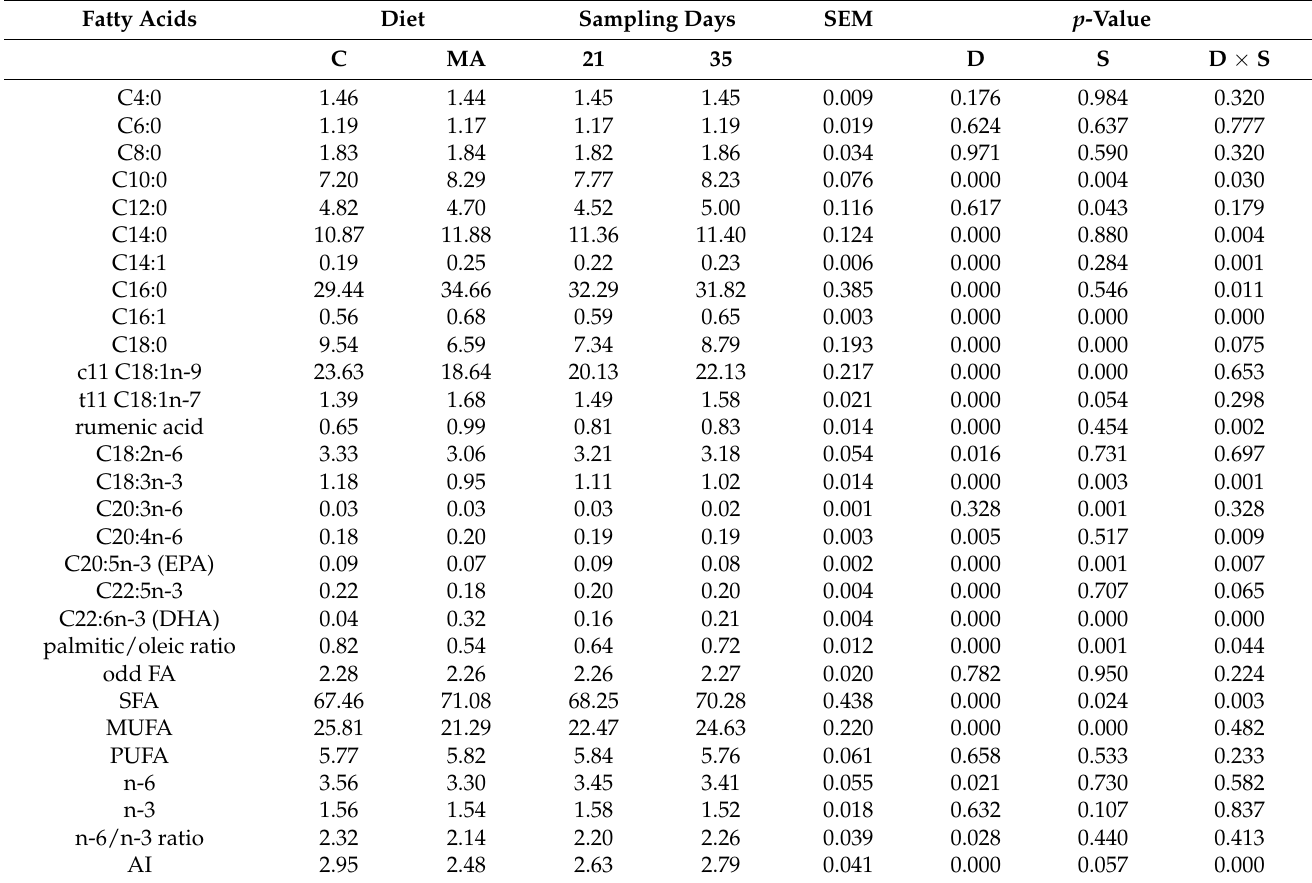
Table 4. Fatty acid profile of goat milk from different feeding treatments (g/100 g of fatty acids). Fatty Acids Diet Sampling Days